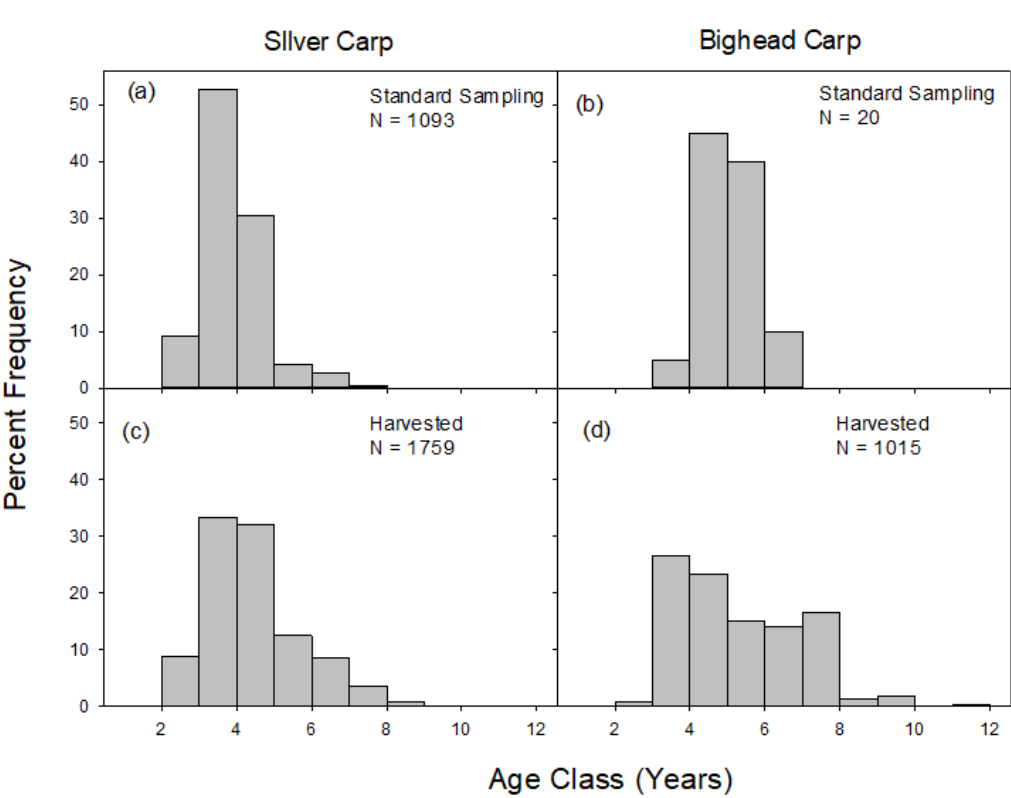
Figure 4. Percent frequency of ages of ( a ) silver carp and ( b ) bighead carp sampled with standardized gear and harvested by fishers ( c , d ) in the lower Illinois River during 2012.